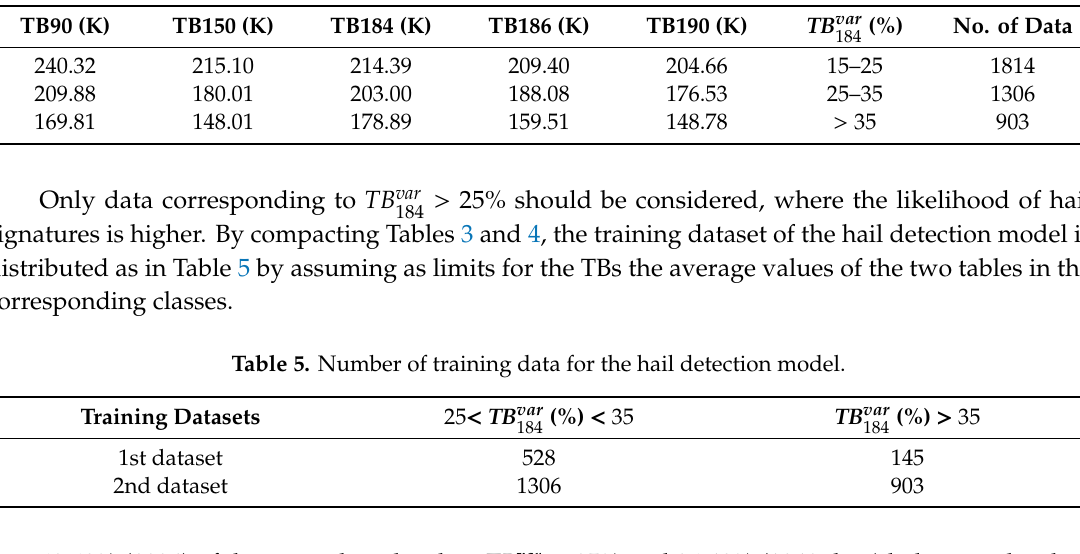
Table 4. AMSU-B average TBs by threshold TB var for the training period 2000–2009.